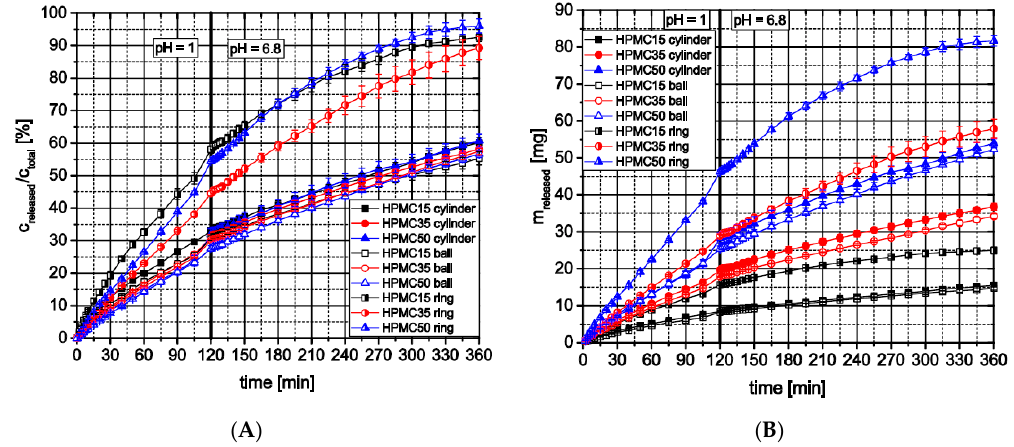
Figure 11. In vitro theophylline release from HPMC-based 3D-printed dosage forms using flow through apparatus; ( A ) relative release; ( B ) total release; n = 3.